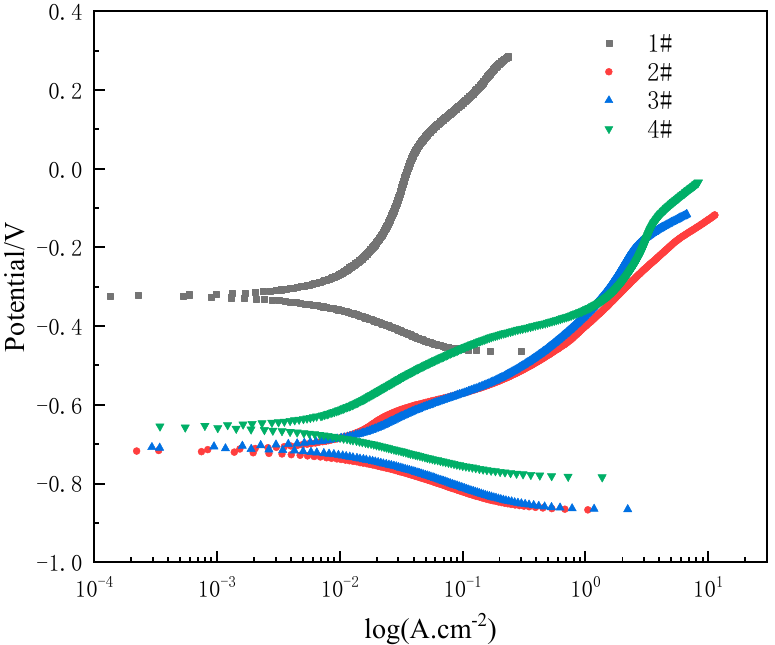
Figure 9. XRD patterns of different coatings after salt spray test. Table 5. Atomic percentage content measured by EDS.